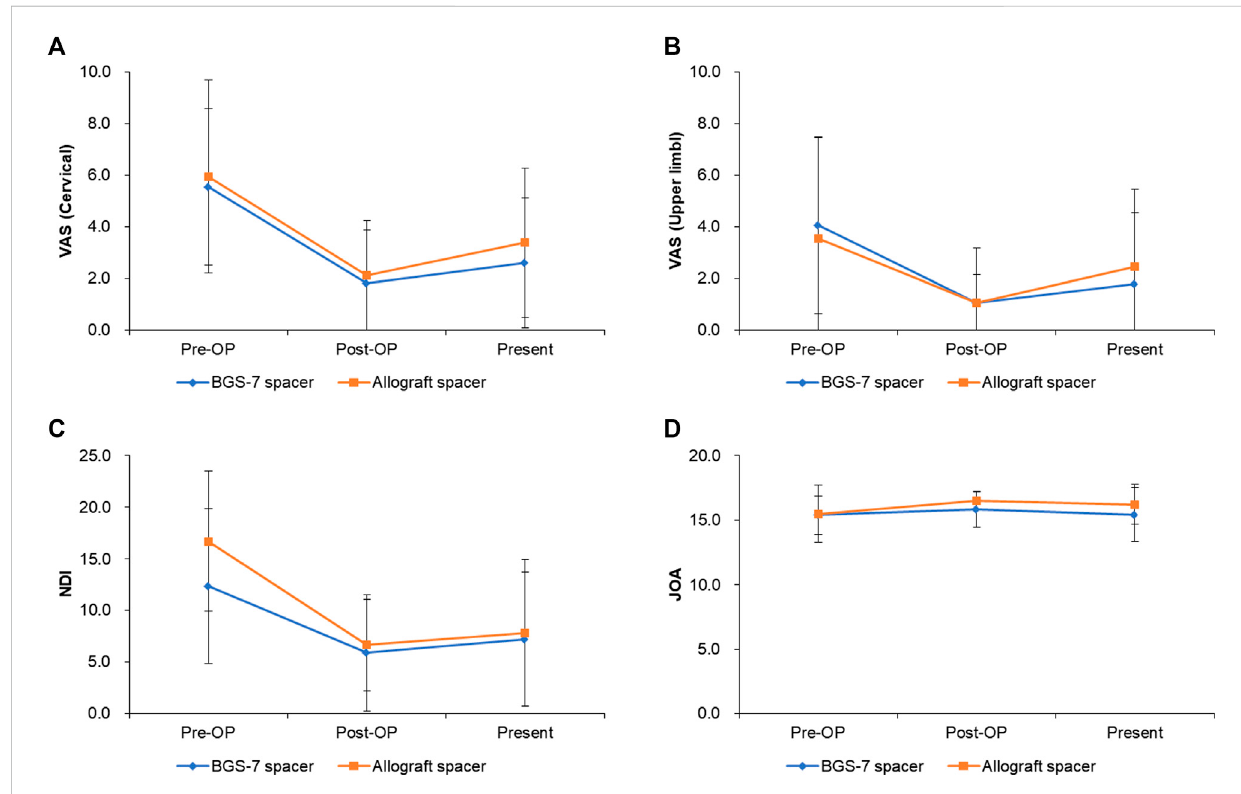
FIGURE 4 Clinical outcomes for each group after ACDF surgery during 5 years. (A) VAS (cervical), (B) VAS(upper limb), (C) NDI, (D)